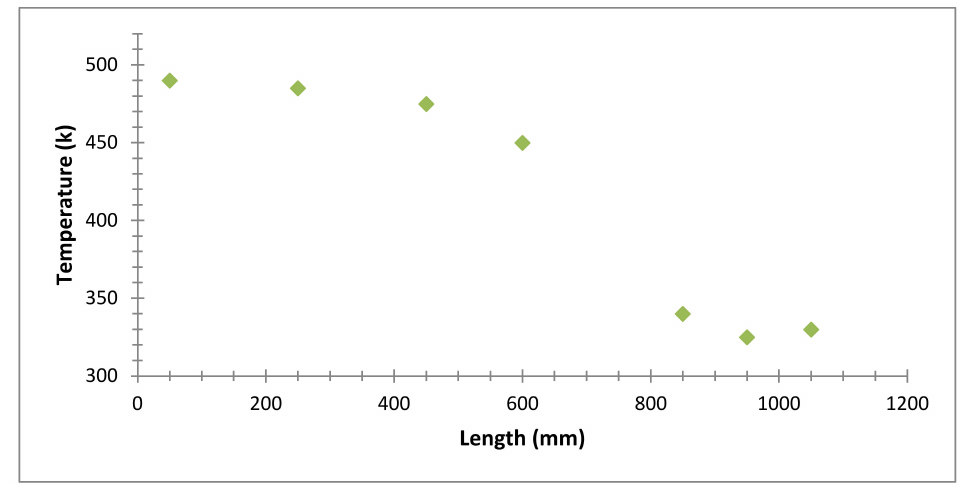
Figure 13. Steady state temperature distribution on TPCT for FR =